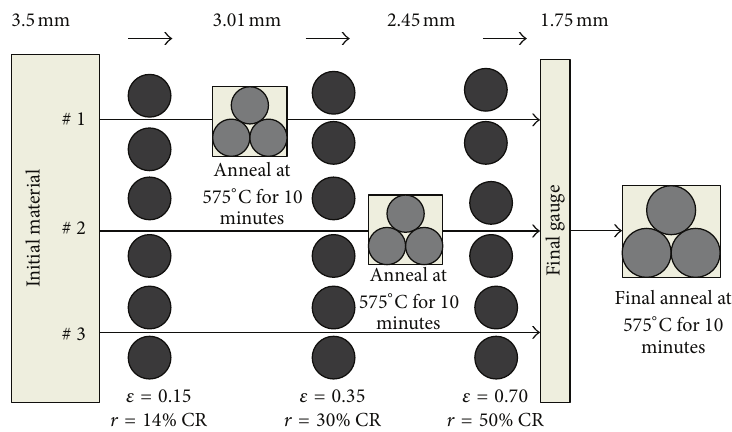
Figure 1: Sheet fabrication with and without process-annealing.